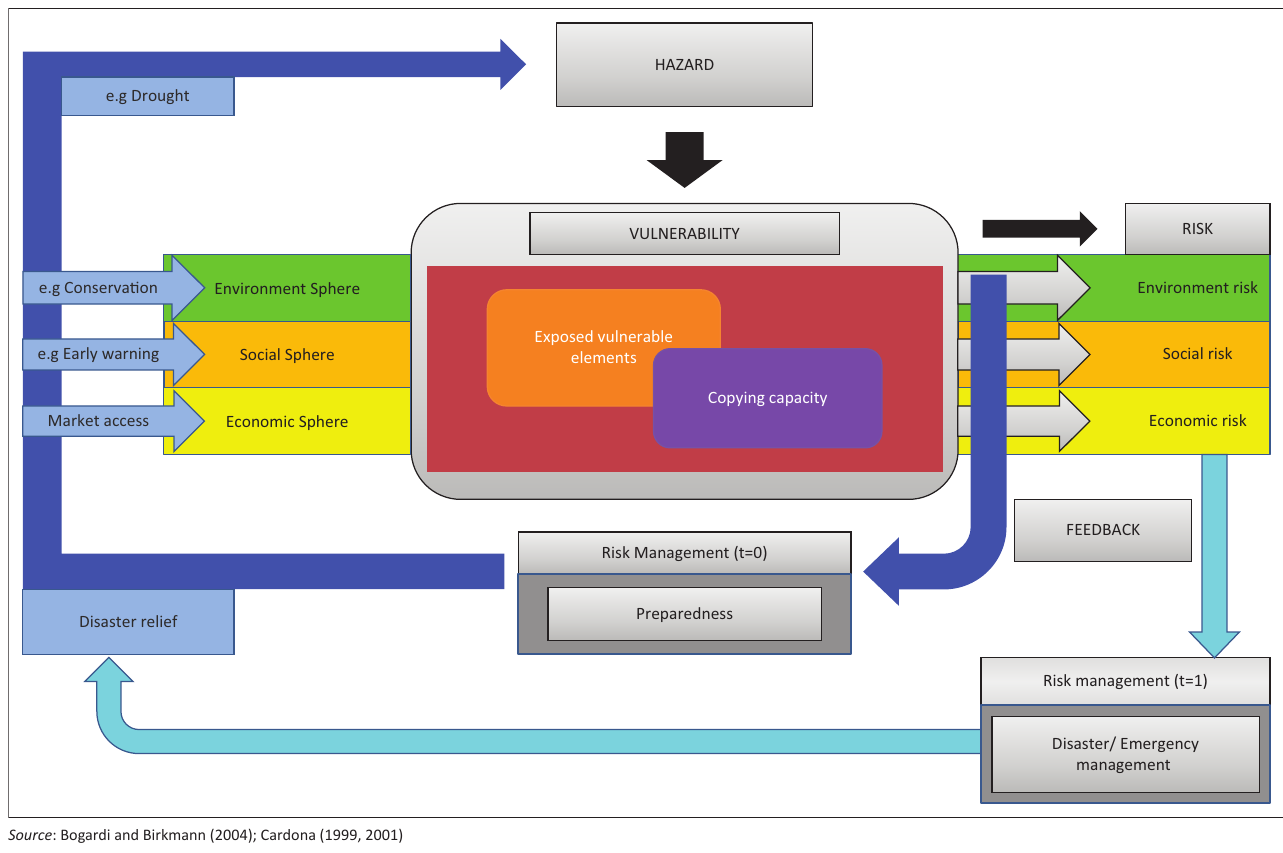
FIGURE 1: Conceptual framework for vulnerability. TABLE 1: Selected social vulnerability